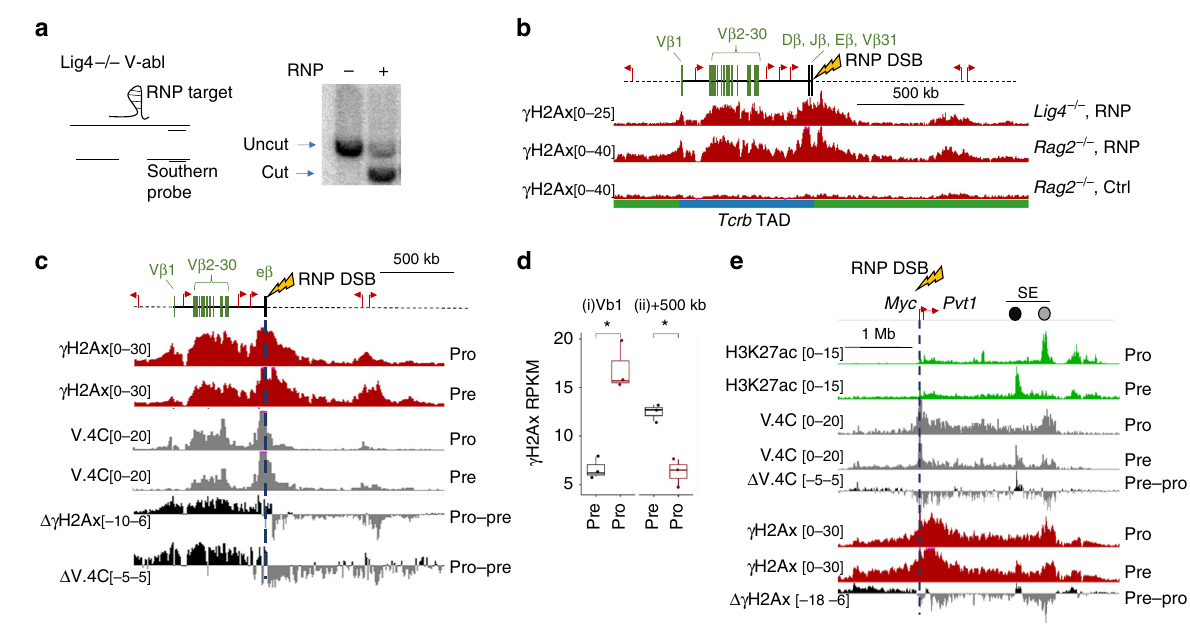
Fig. 2 Contact-dependent γ H2Ax pro fi les in a tractable cell model. a Southern blotting analysis for DSBs targeted to the E β enhancer in Tcrb . Bands corresponding to uncut (top band) or cut (bottom band) loci are indicated. Genomic DNA was harvested 4 h after Lig4 − / − or Rag2 − / − v-abl cells were nucleofected with an RNP targeting E β . See Supplementary Fig. 2A for replicates. b UCSC genome browser tracks showing γ H2Ax CR-seq performed 2 h after Lig4 − / − or Rag2 − / − v-abl cells were nucleofected with RNP-E β ( n = 2, representative of independent replicates). Tcrb gene segments, neighboring genes (red arrows) and the DSB location (lightning bolt) are shown at the top. TAD locations are indicated on bottom. c UCSC genome browser tracks showing the Tcrb loci in pro- (63 – 12 cell line) or pre-lymphocyte cell lines (p5424). For each panel, the locations of gene segments, regulatory elements, and RNP target (lightning bolt and dashed line) are shown at the top. Tracks represent values for γ H2Ax CR-seq (red, RPKM, n = 3, representative of independent replicates), V.4C (gray, interaction count, n = 2 merged independent replicates). In panels with interactome data, V.4C is extracted from the DSB site (dark blue line). c , e include subtraction plots (labeled Δ ) for γ H2Ax and V.4C data, showing differences in (mean of independent replicates) signal from pro- versus pre-lymphocytes. d Box and whisker plot showing γ H2Ax in 25 kb bins after pre- (p5424: gray) or pro- (63 – 12: gray) lymphocyte cell lines were nucleofected with an RNP-E β . Data points show three biologically independent replicates. Means, quartiles, and outlier limits (1.5 × interquartile range) are indicated by the median line, box and whiskers, respectively. Relative locations are indicated above the graph. * p < 0.05, two-sided Paired Student ’ s T test. Enrichment and statistics for all bins across the Tcrb locus is shown in Supplementary Fig. 2C. e UCSC genome browser tracks showing the Myc locus, as in ( c ). Green tracks represent H3K27ac CR-seq (green, RPKM, n = 1). Cell type-speci fi c H3K27ac + regions near the Myc Super- Enhancer (SE) are indicated by colored dots, showing positions for pre- (black) or pro- (gray) lymphocyte